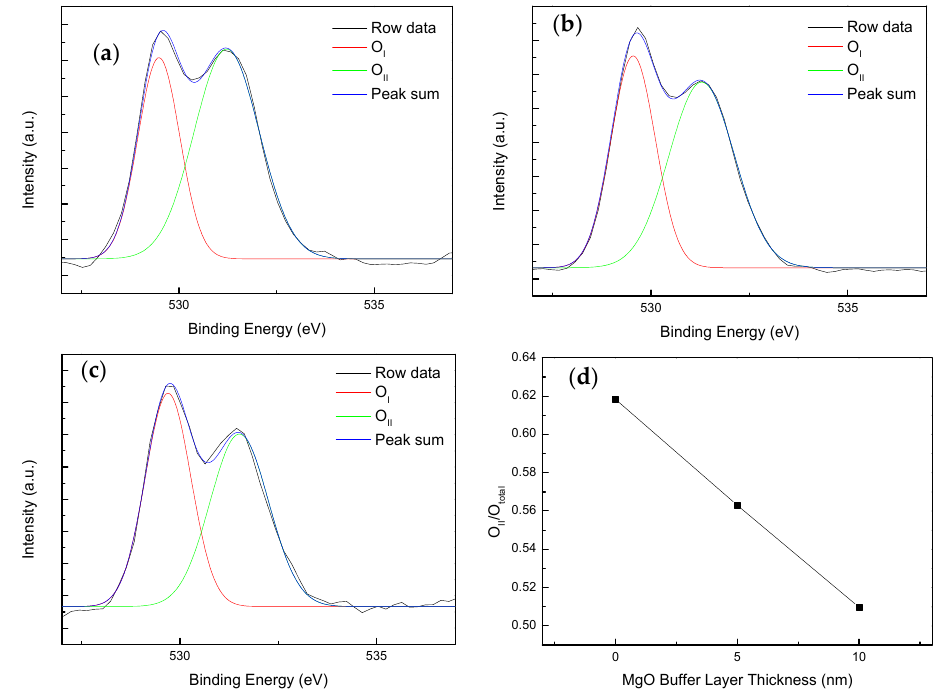
Figure 4. XPS O 1s spectra of MIO thin films ( a ) without MgO buffer layer, ( b ) with 5 nm-thick MgO buffer layer, ( c ) with 10 nm-thick MgO buffer layer, ( d ) O II /O total ratios of MIO thin films with various thickness of MgO buffer layer.